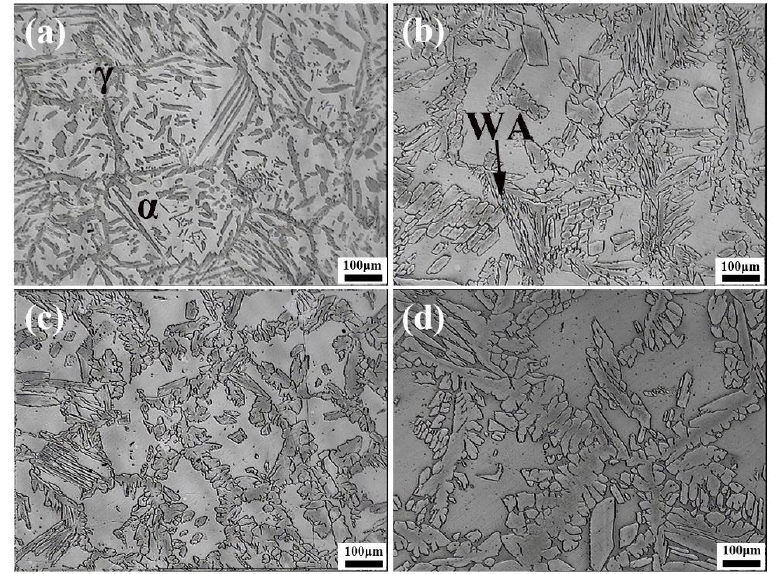
Figure 2. Microstructure of specimens with different heat inputs: ( a ) 5 kJ/cm; ( b ) 15 kJ/cm; ( c ) 25 kJ/cm; ( d ) 35 kJ/cm. α stands for the ferrite phase and γ represents the austenite phase. WA means the Widmanstatten-type austenite.